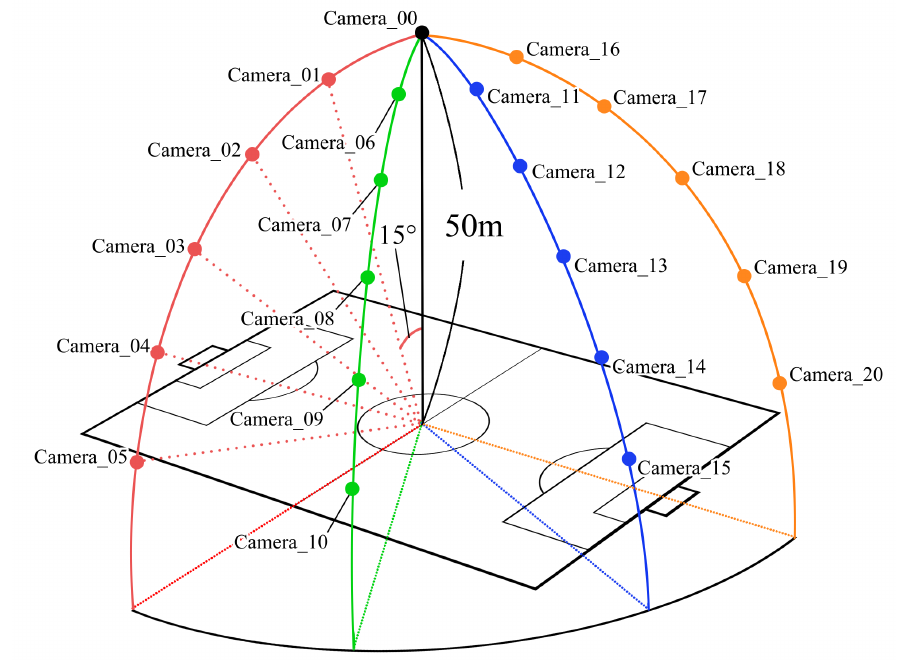
Figure 6. Overview of camera